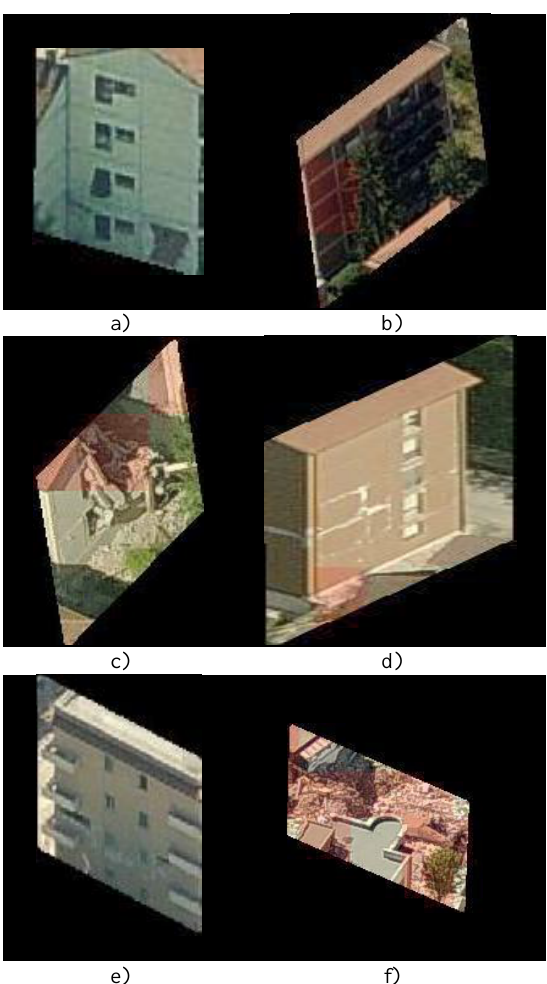
Figure 9. Several examples of classification with the mono- temporal traditional approach. Red squares indicate damaged regions within each façade